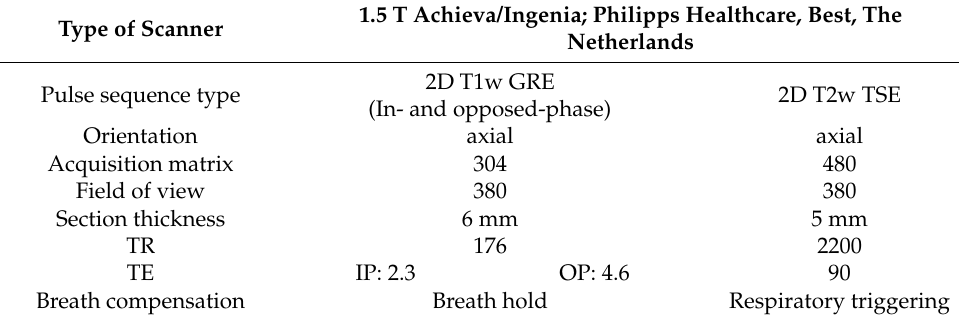
Table 1. Technical data MRI